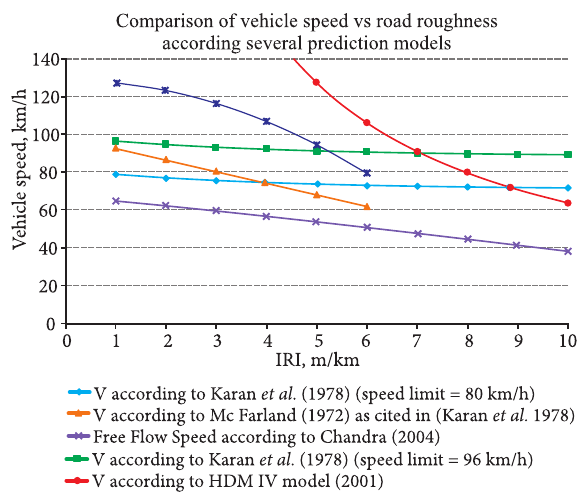
Fig. 8. Comparison with different speed-roughness model derived from